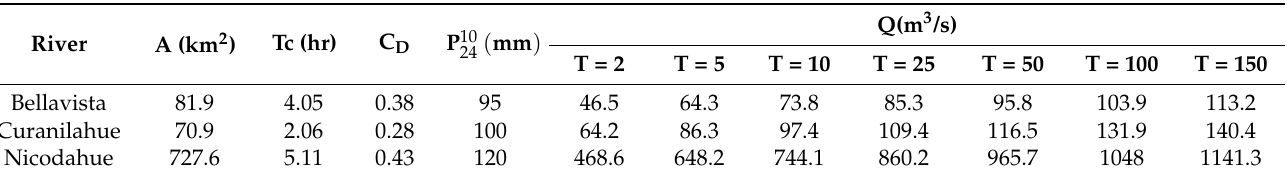
Table 1. Parameters and flows calculated using the rational method for different return periods for the Bellavista, Curanilahue, and Nicodahue